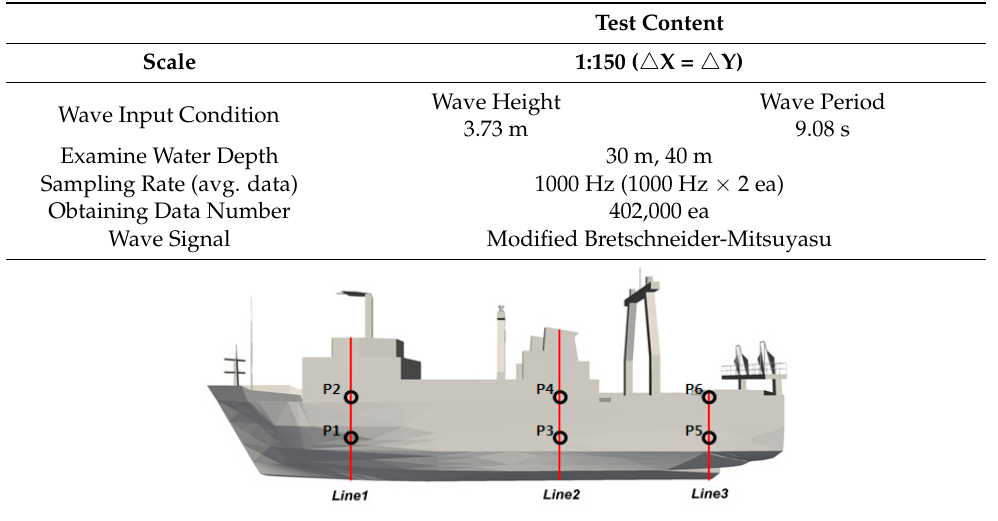
Table 5. Details of the wave pressure measurement experiment set-up.